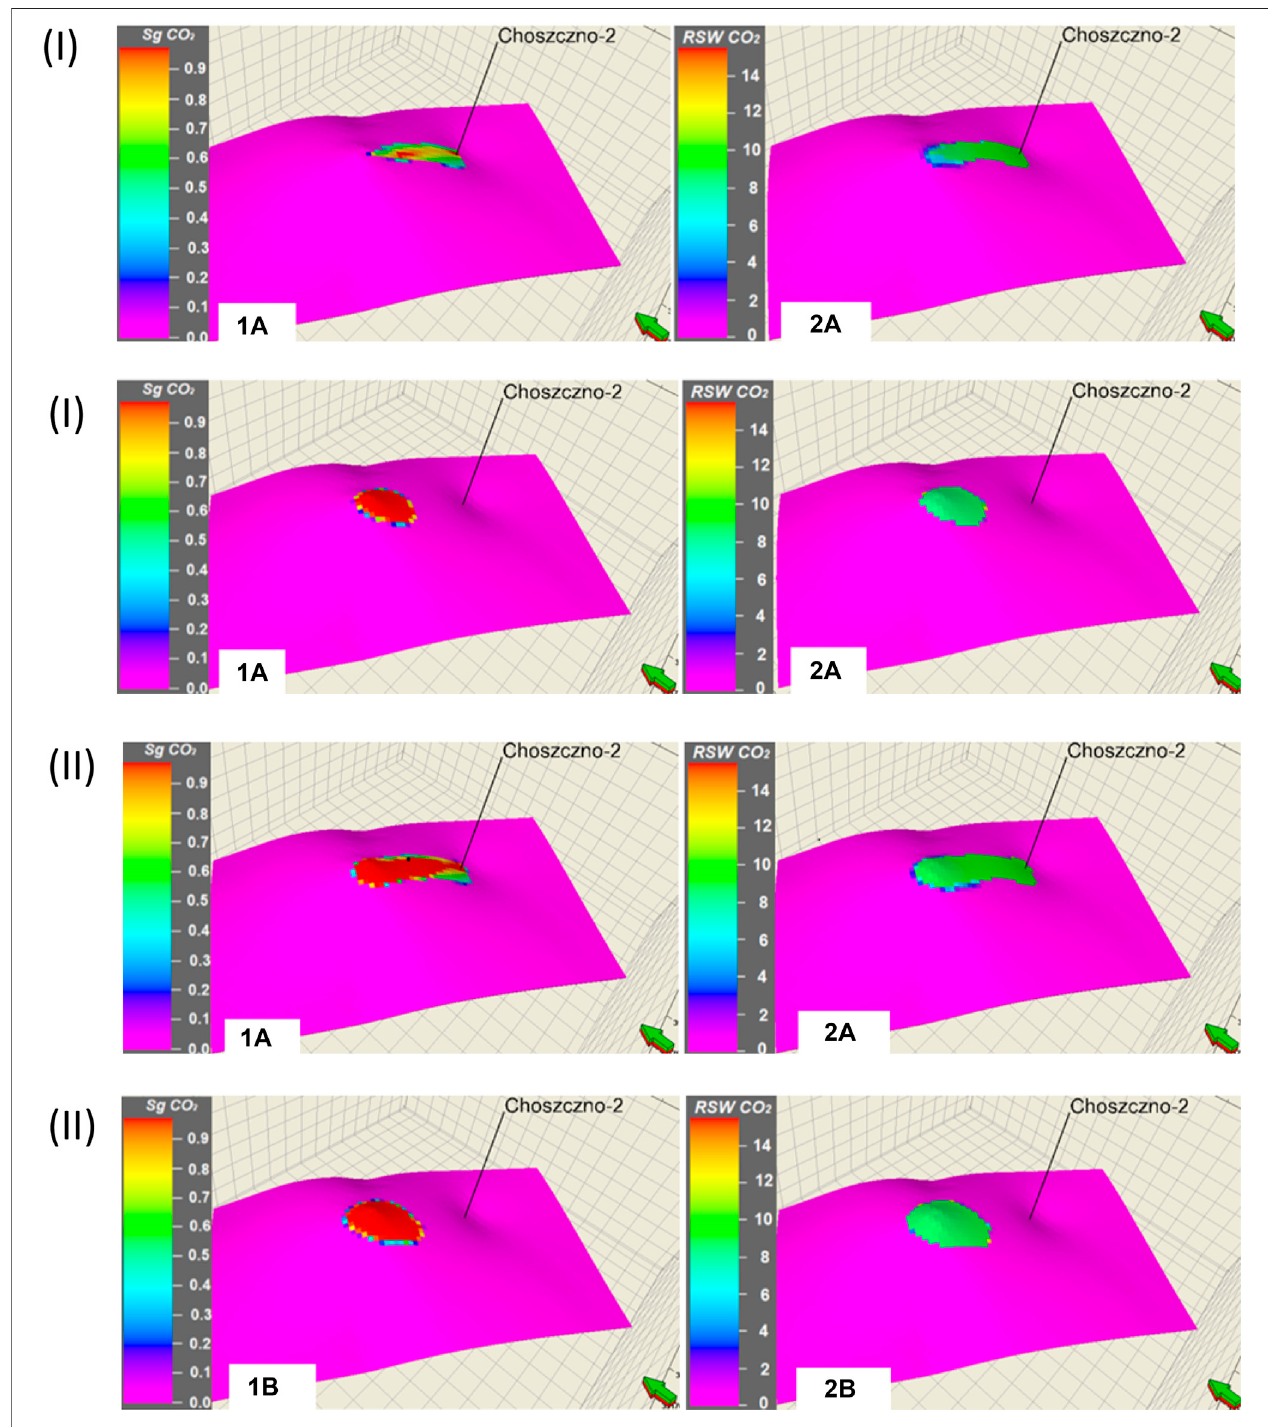
FIGURE10| DistributionofsaturatedfreeCO 2 (1) anddissolvedCO 2 (2) inthe (I) Pliensbachiancollectorrooflayerand (II)(A) andinthesealingrooflayer (B) inthe sealing roof layer of the Toarcian after 25 years of injection.